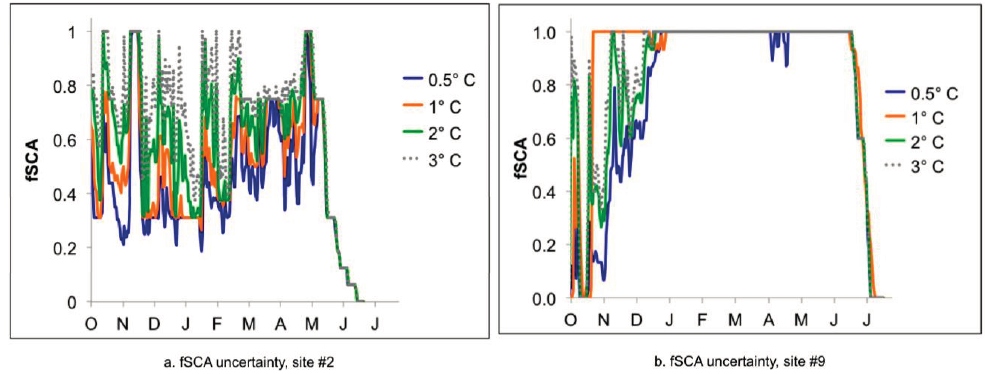
Figure 14. Results from sensitivity analysis indicating 60 m grid cell snow cover fraction using 0.5 °C, 1 °C, 2 °C, and 3 °C temperature thresholds for ( a ) an example site with partially snow-covered conditions throughout the winter and spring (site #2) and ( b ) for an example site with consistent fully snow-covered conditions throughout the winter and spring (site #9).